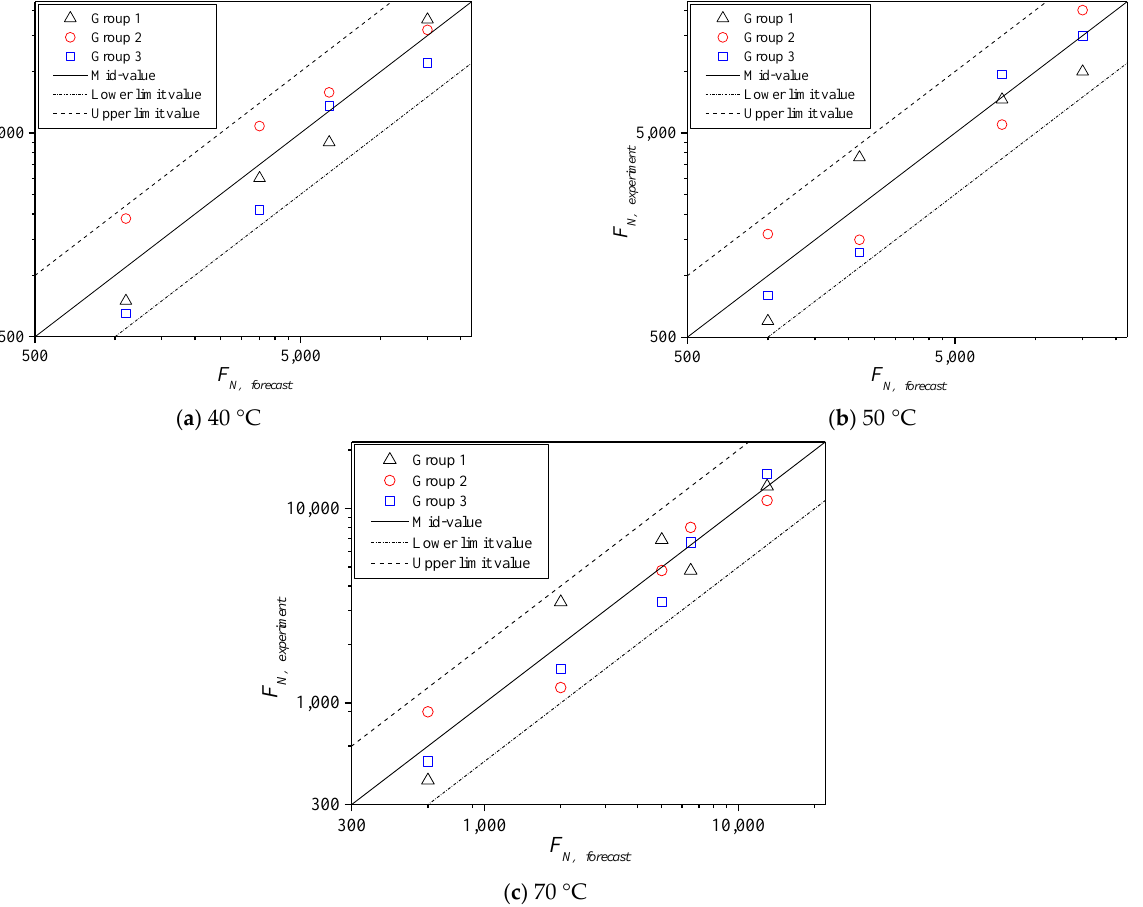
Figure 16. Distribution of F N at different temperatures.